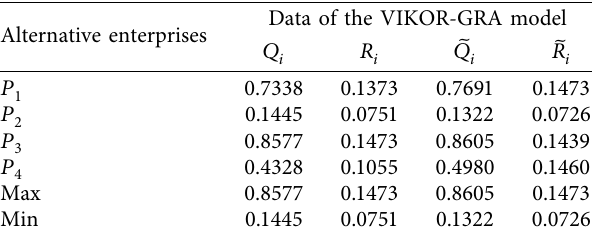
Table 5: Relevant data of the VIKOR-GRA model.